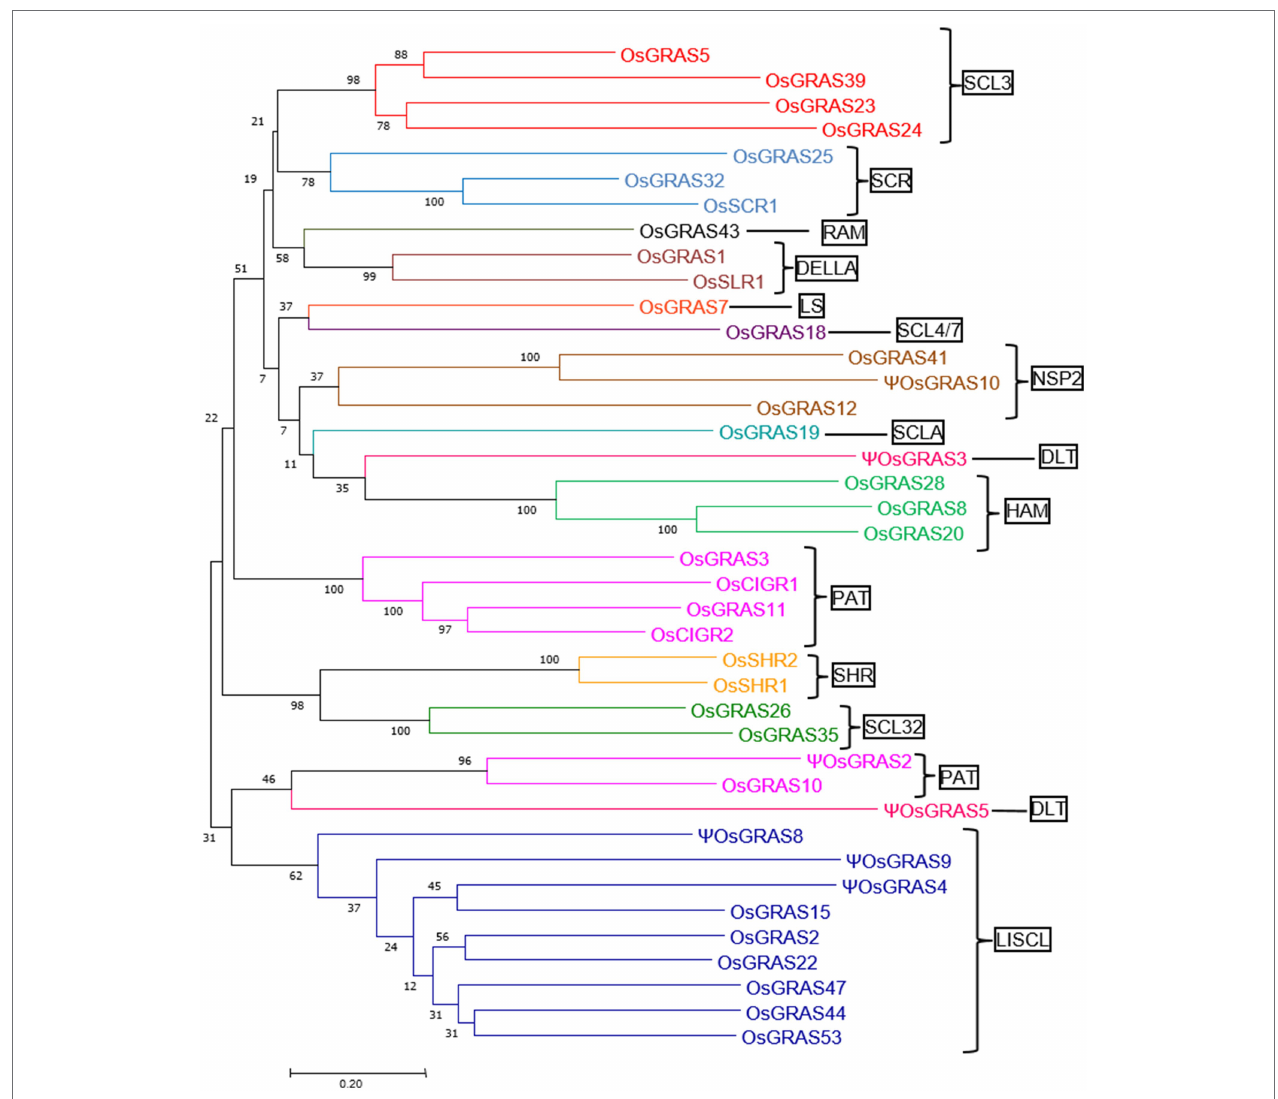
FIGURE 2 | Phylogenetic analysis of OsGRAS genes. An unrooted phylogenetic tree showing the evolutionary relationship of OsGRAS genes. The tree was constructed using the Neighbour Joining method in MEGA7 software with a bootstrap value of 1,000. The number at each node represents the percentage bootstrap values. Based on the previous literature, the genes have been divided into 14 subfamilies (mentioned in boxes) and each subfamily has been colour